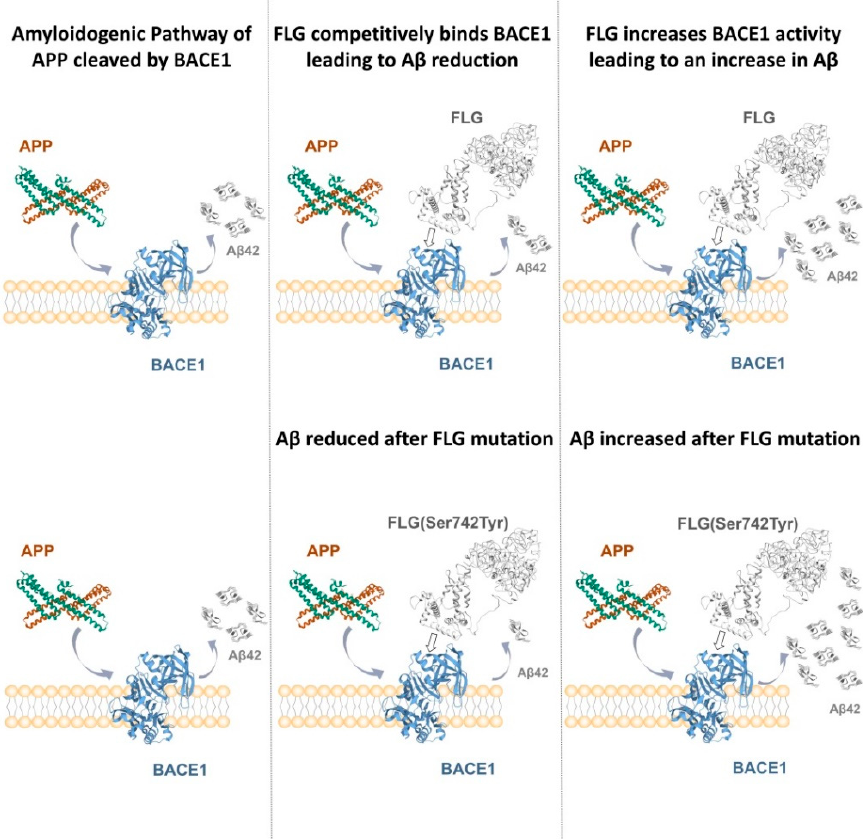
Figure 4. Hypothetical theoretical pathway figure of FLG and its mutant FLG (Ser742Tyr) on A β 42 accumulation.